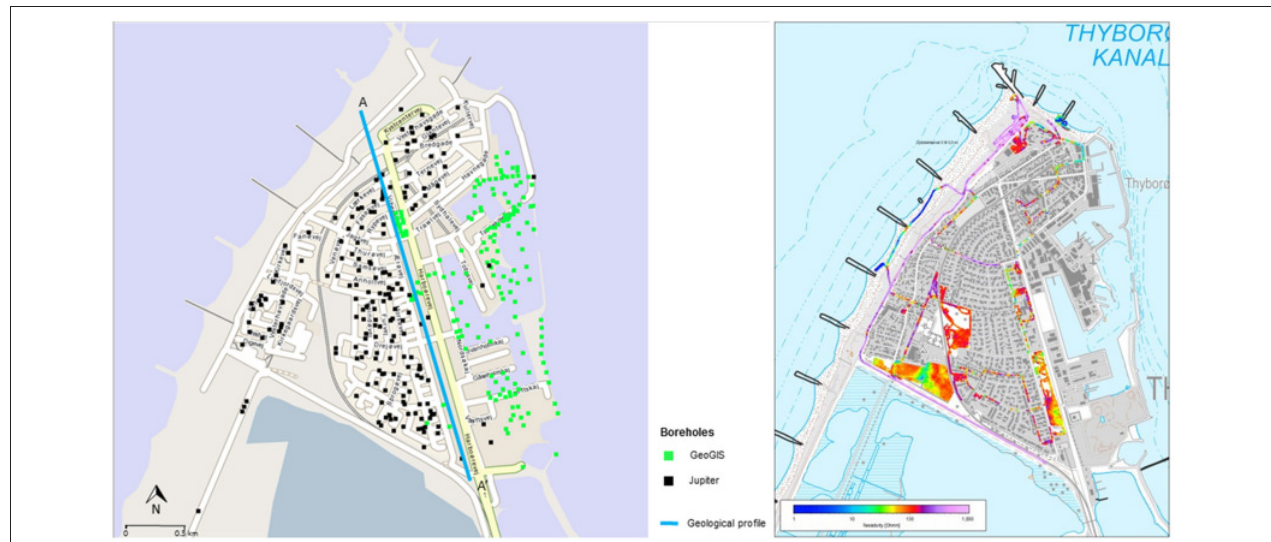
FIGURE 4 | Available subsurface data for Thyboron. The green dots indicate wells from Geo’s well database and black dots show wells available from the public Jupiter database. The blue line indicates the position of the geological profile A-A ′ . DUALEM-421s data coverage is exemplified by resistivity measurements at 1–1.5m depth (right).